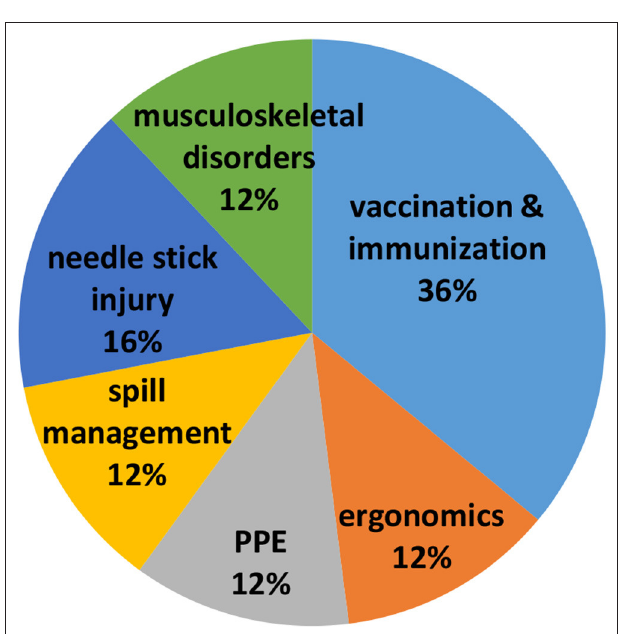
FIGURE 2 | Usefulness of content as per participants’